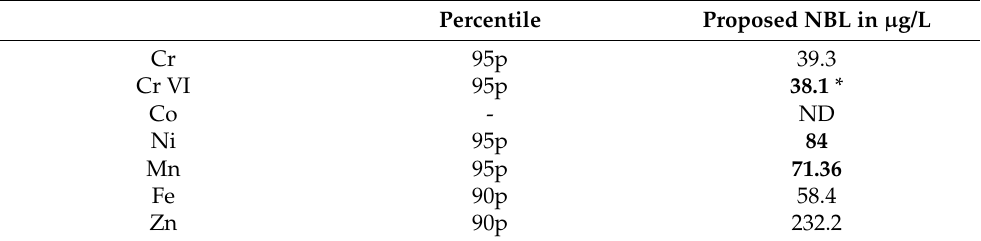
Table 9. Proposed natural background levels (NBLs) for PTEs in the study area. These correspond to the 95p values calculated for all the available measurements, excluding the two MSs with low redox potential (for Cr, Cr VI, Ni and Mn), and to the 90p values for Fe and Zn. In bold, the NBLs exceeding the TVs [15]. For Cr VI, the NBL is not representative of the BPA. Percentile